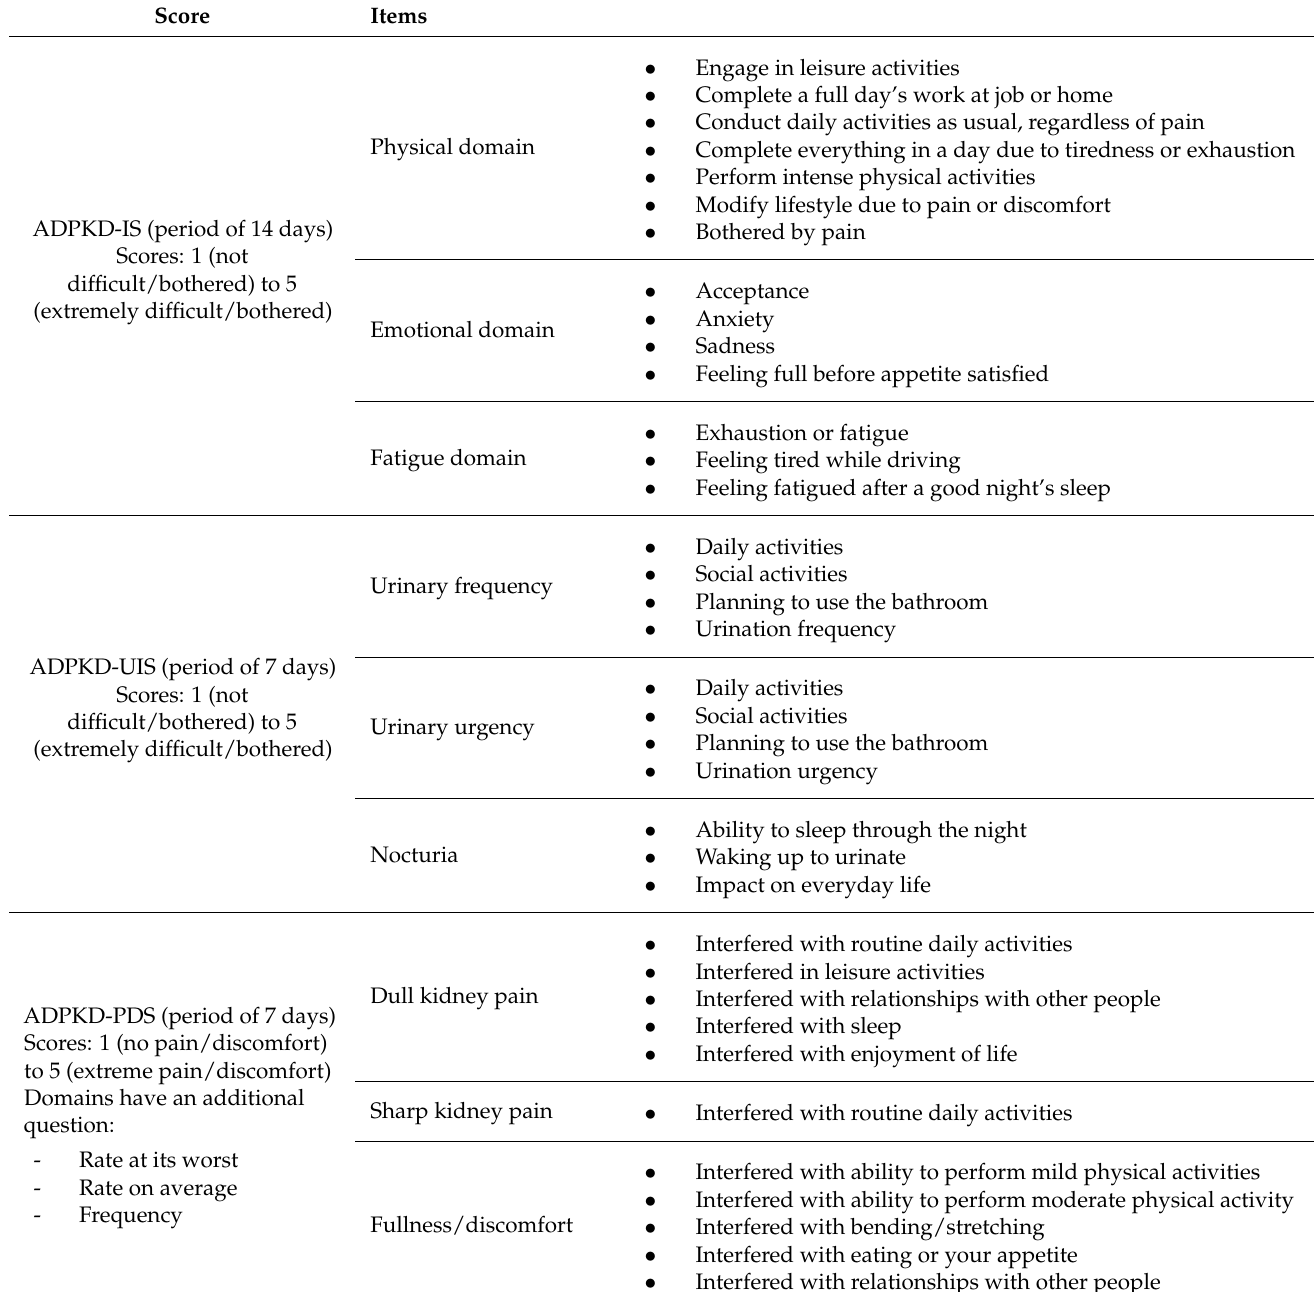
Table 1. Summary of quality of life scores in